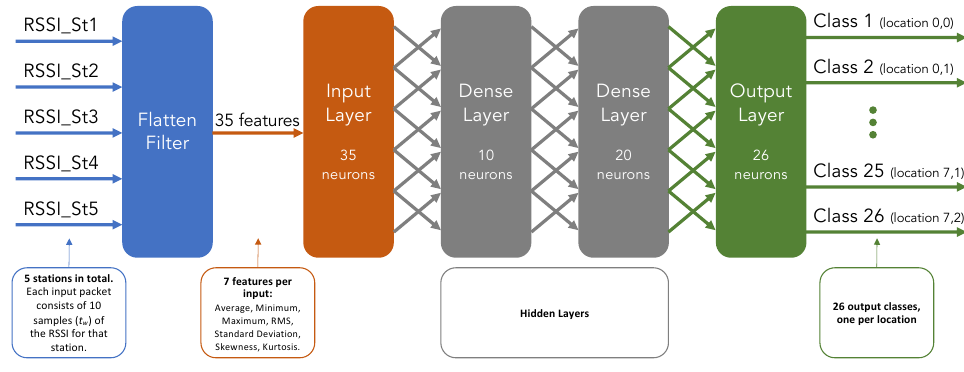
Figure 12. Final structure of the implemented and deployed neural network.